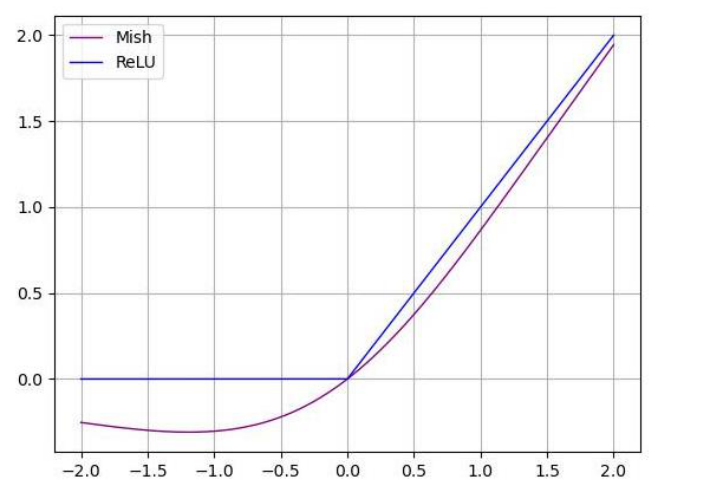
Figure 5. The activation function diagram of Mish and